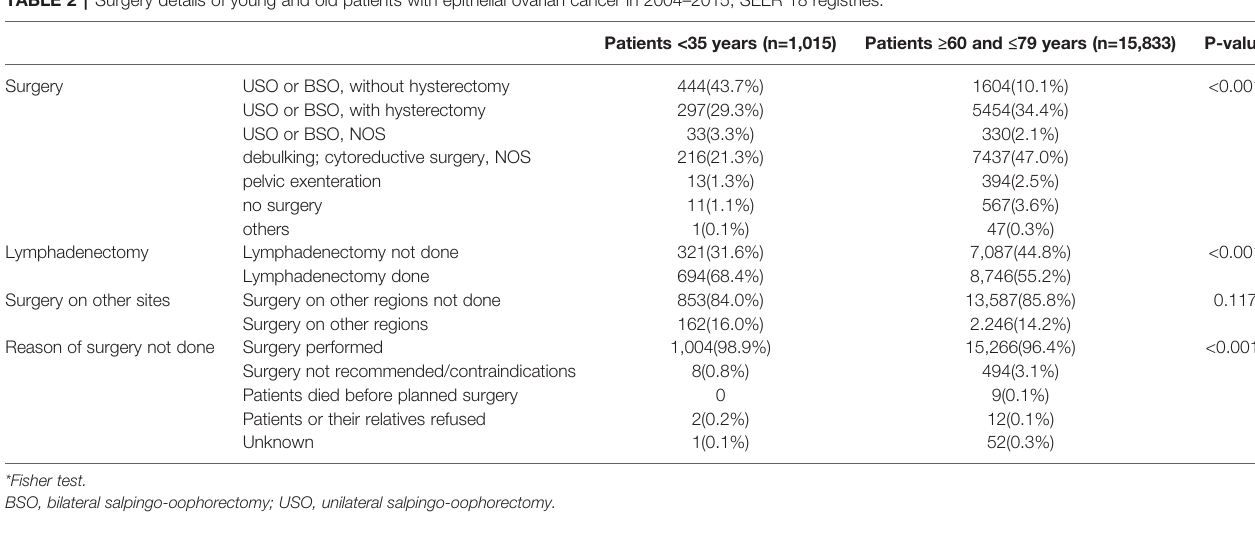
TABLE 2 | Surgery details of young and old patients with epithelial ovarian cancer in 2004 – 2015, SEER 18 registries.